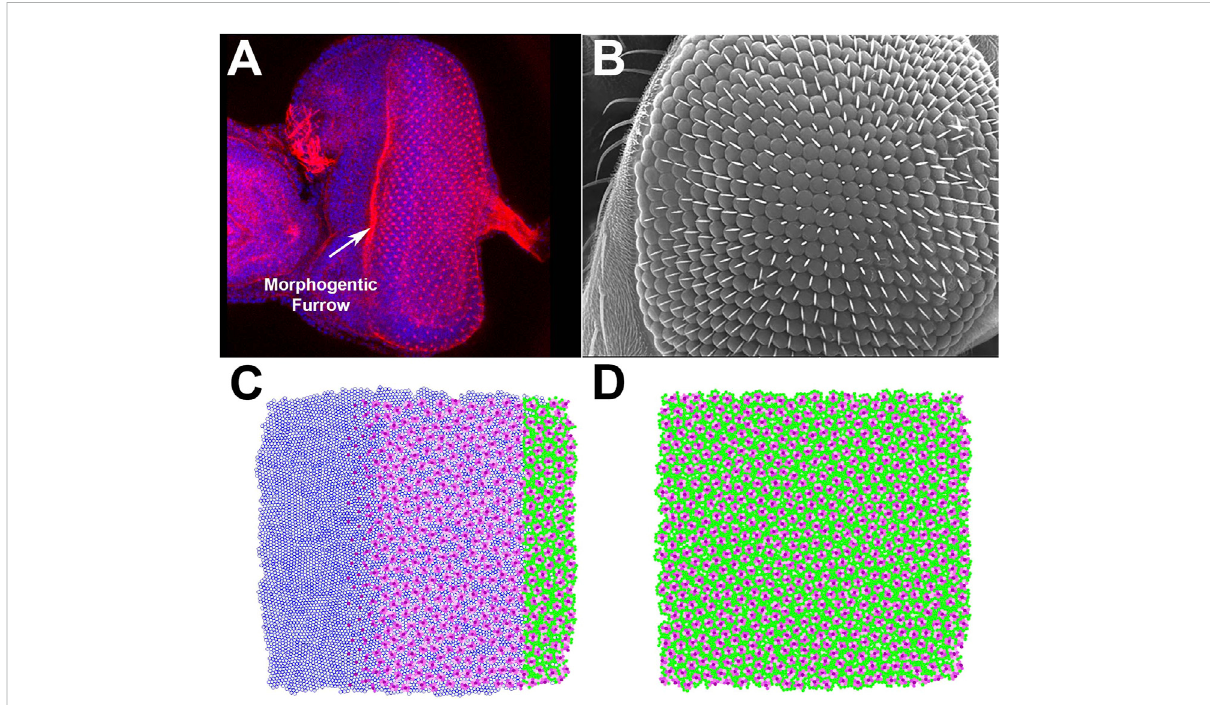
FIGURE 2 Proof-of-principle test of the ability of EyeVolve to recapitulate the eye layout of Drosophila melanogaster . (A) . DAPI and phalloidin staining of the developing adult eye at the late third larval instar stage. (B) . Scanning electron micrograph of the surface of an adult Drosophila eye, illustrating thepreciseandregularpositioning ofommatidia. (C) .EyeVolveimagetakenduring thesimulation toillustratehowommatidia develop progressively from right to left. (D) . EyeVolve image of a fully developed compound